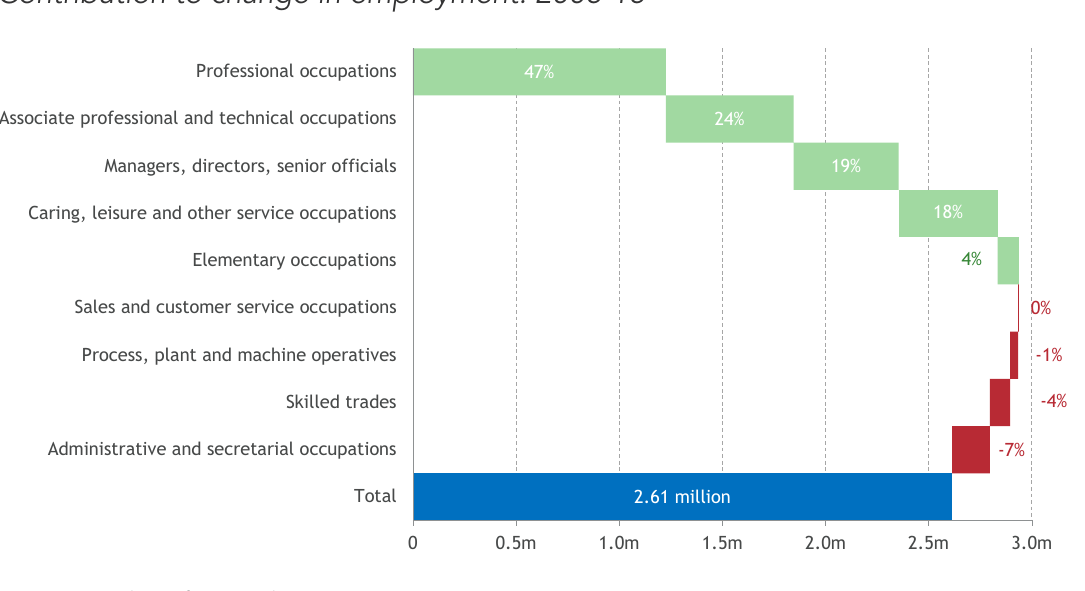
Figure 20: Professional and technical occupations account for the majority of the net increase in employment in the past decade Contribution to change in employment: